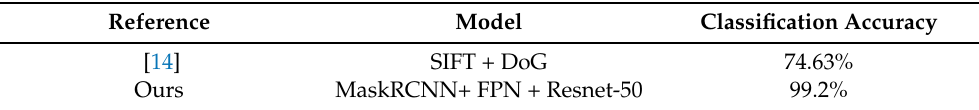
Table 4. Comparison with the existing